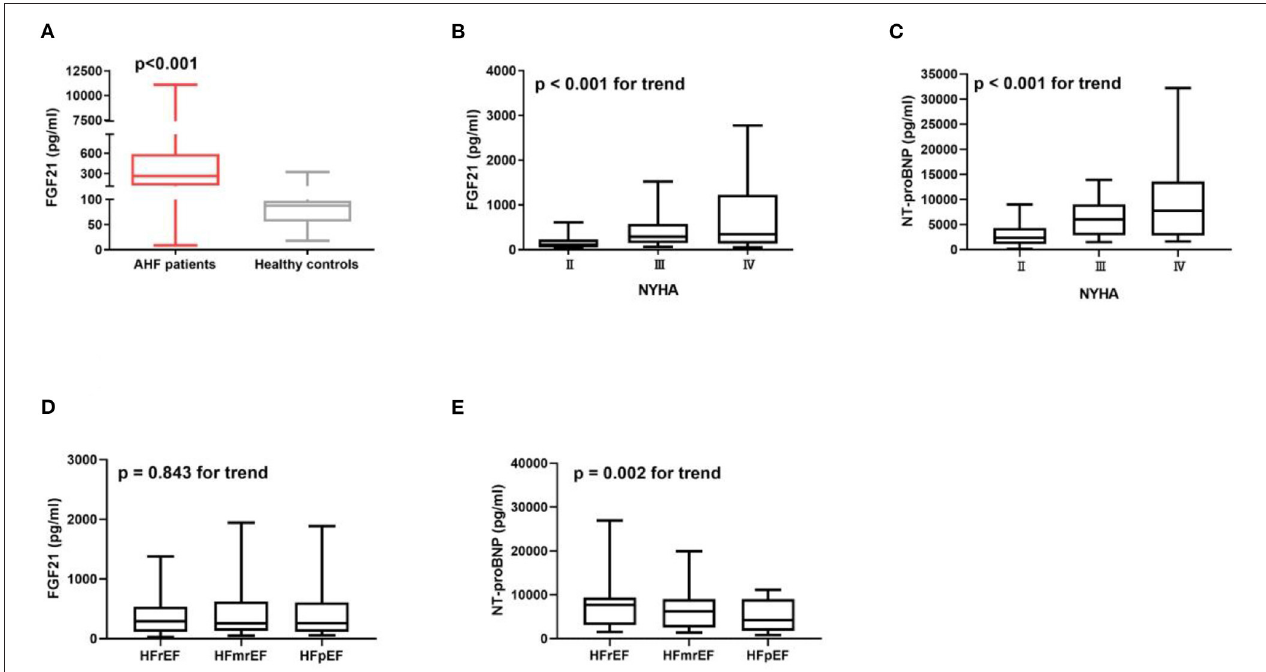
FIGURE 2 | Serum FGF21 is higher in AHF patients ( n = 402) compared to the healthy controls ( n = 19) ( p < 0.001) (A) . Concentration of FGF21 (B) and NT-proBNP (C) were increased with the increase in New York Heart Association (NYHA) functional class ( p < 0.001 for trend). NT-proBNP gradually decreased from HFrEF, HFmrEF to HFpEF patients ( p = 0.002 for trend) (E) , but not FGF21 ( p = 0.843 for trend) (D)